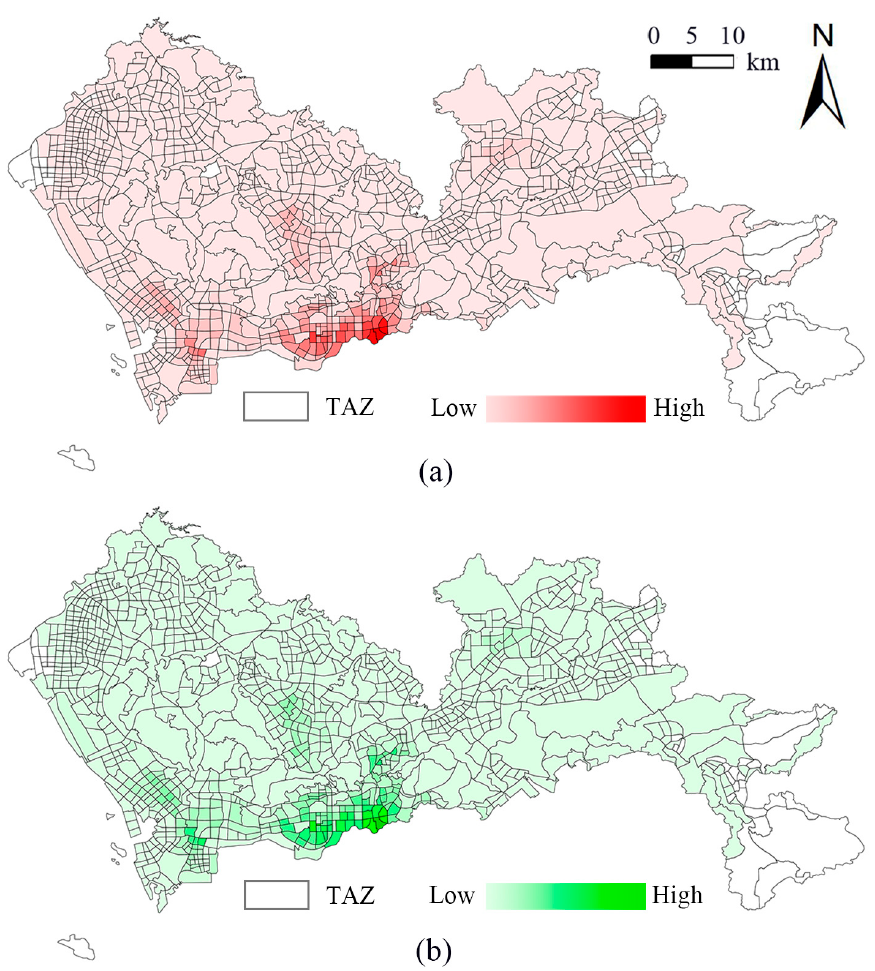
Figure 2. The spatial distribution of ASR ( a ) and DSR ( b ) on weekdays in Period 1. Table 3. The overall mean of the ASR/DSR, the inner city mean of the ASR/DSR, and the outer city mean of the ASR/DSR on